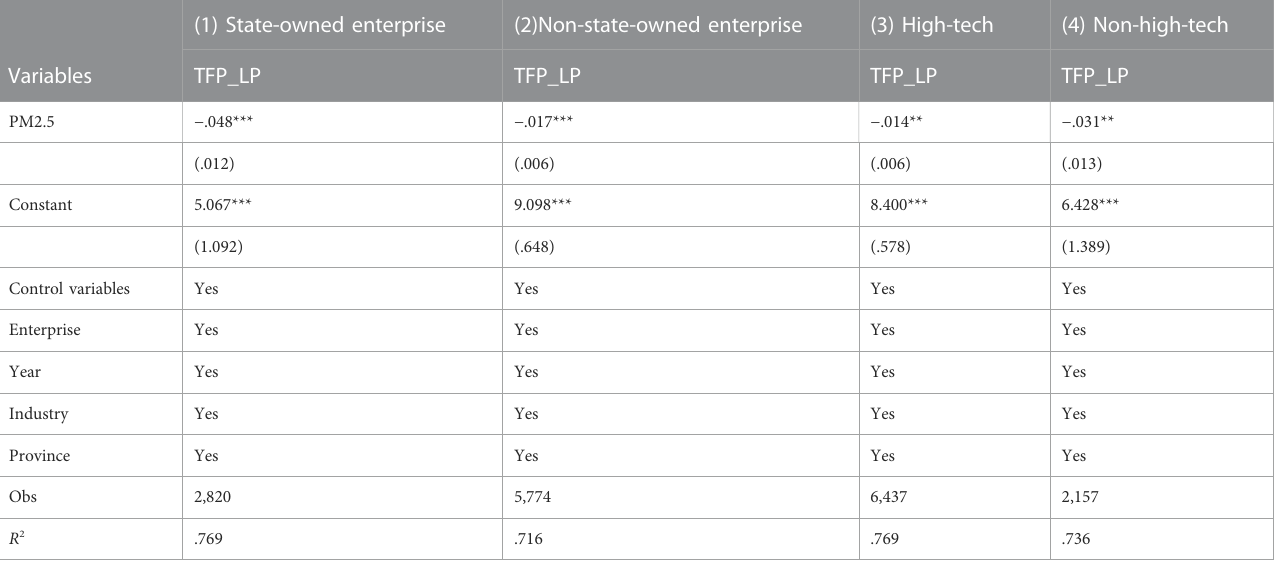
TABLE 9 Heterogeneity: Equity and technical